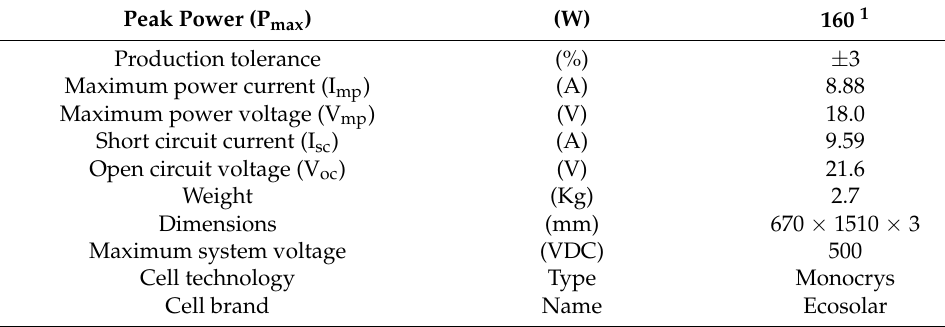
Table 1. PVM technical characteristics.